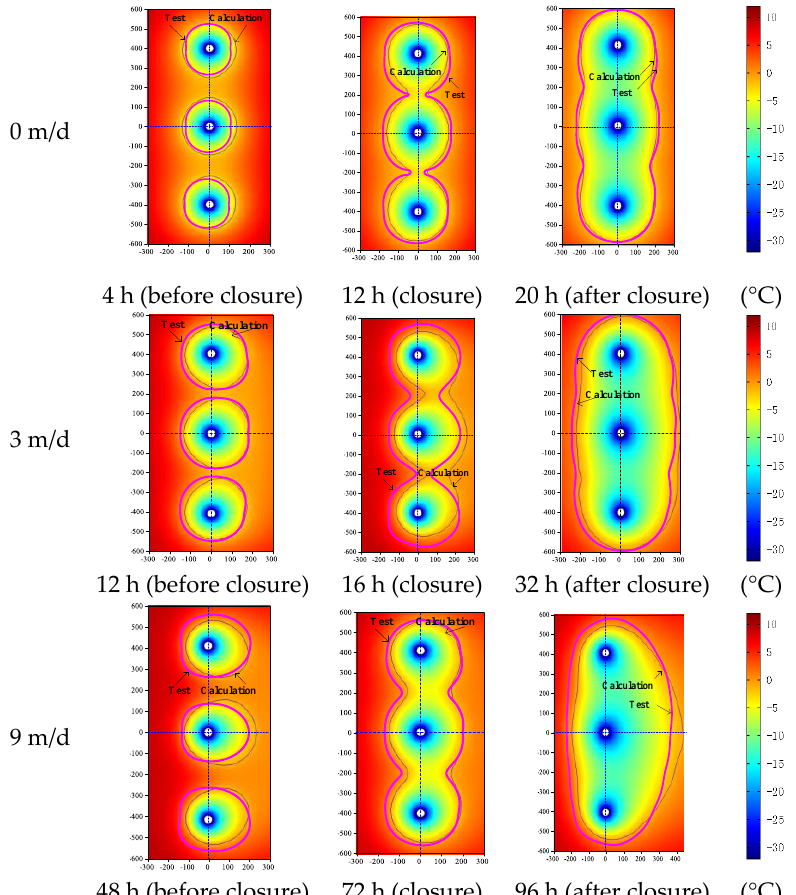
Figure 8. Comparison between simulated and measured results of freezing front under different seepage velocities.